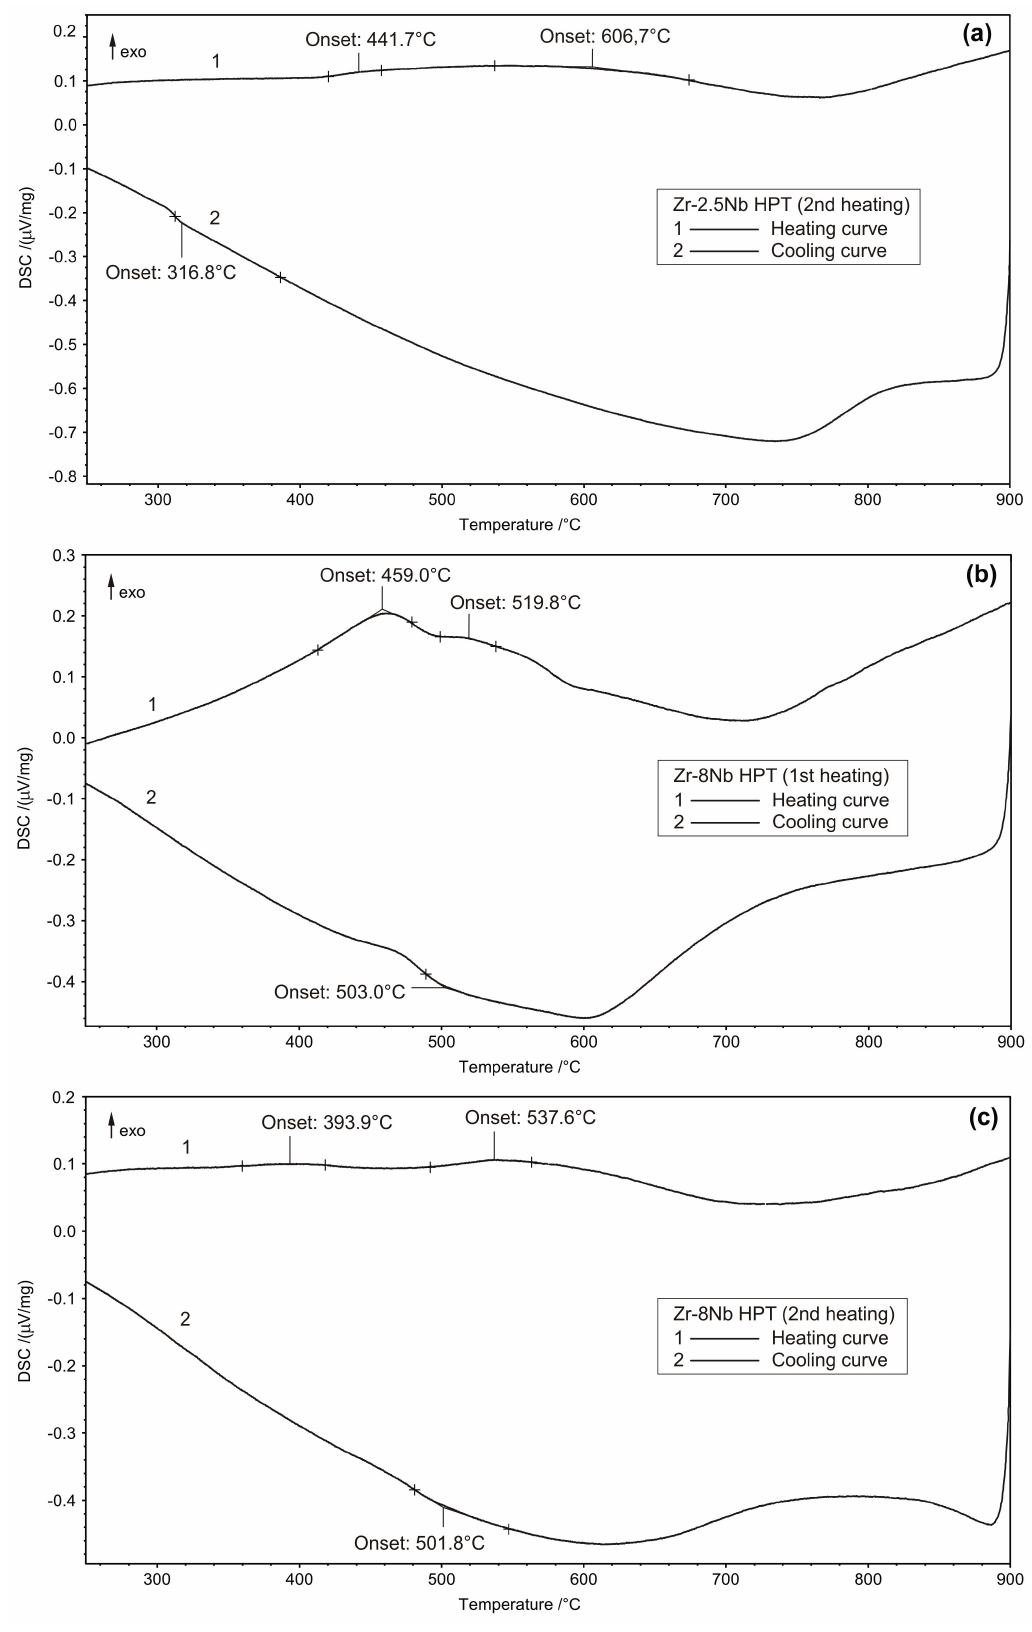
Figure 5. The temperature dependences of heat flow DSC by heating (upper curves) and by cooling (lower curves) for (a) UFG Zr-2.5 mass% Nb alloy after HPT (second heating), (b) UFG Zr-8 mass% Nb alloy after HPT (first heating), (c) UFG Zr-8 mass% Nb alloy after HPT (second